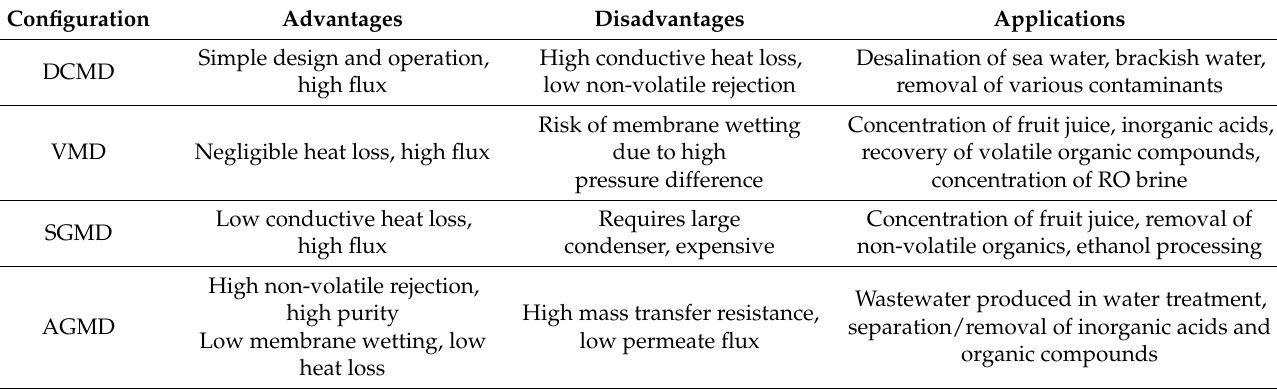
Figure 2. Conventional configurations of membrane distillation [10] . Table 1. MD conventional configurations and their advantages, disadvantages, and applications .